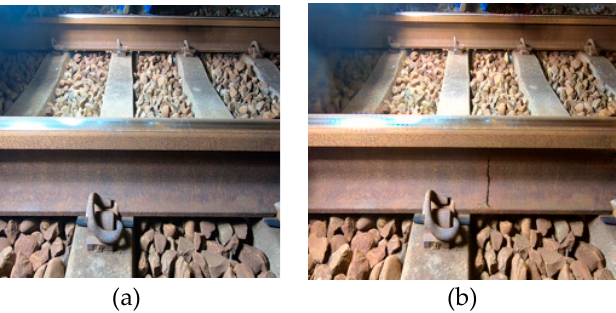
Figure 7. Human synthesized images. ( a ) crack image; ( b ) human ‐ made images.